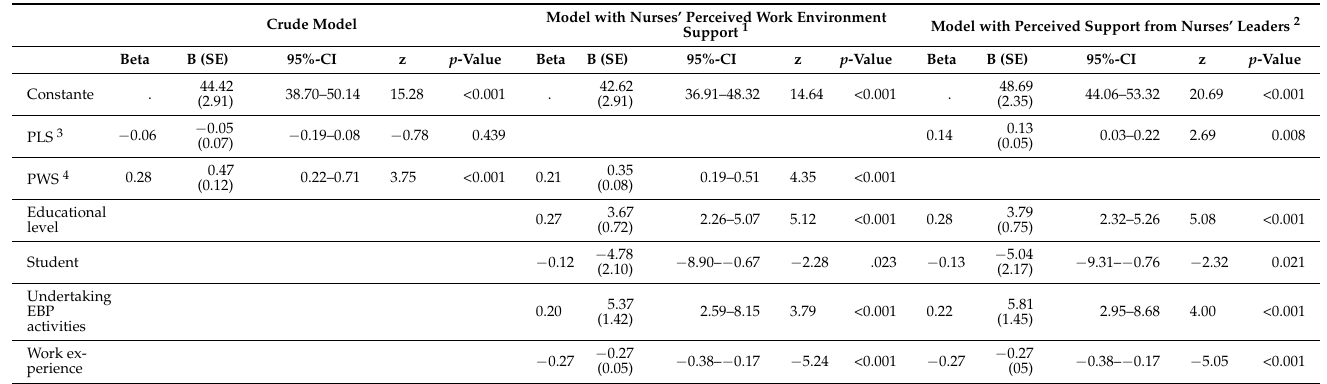
Table 4. Linear mixed model analysis of outcome expectancy in EBP with nurses’ perceived work environment support and perceived nurse leaders’